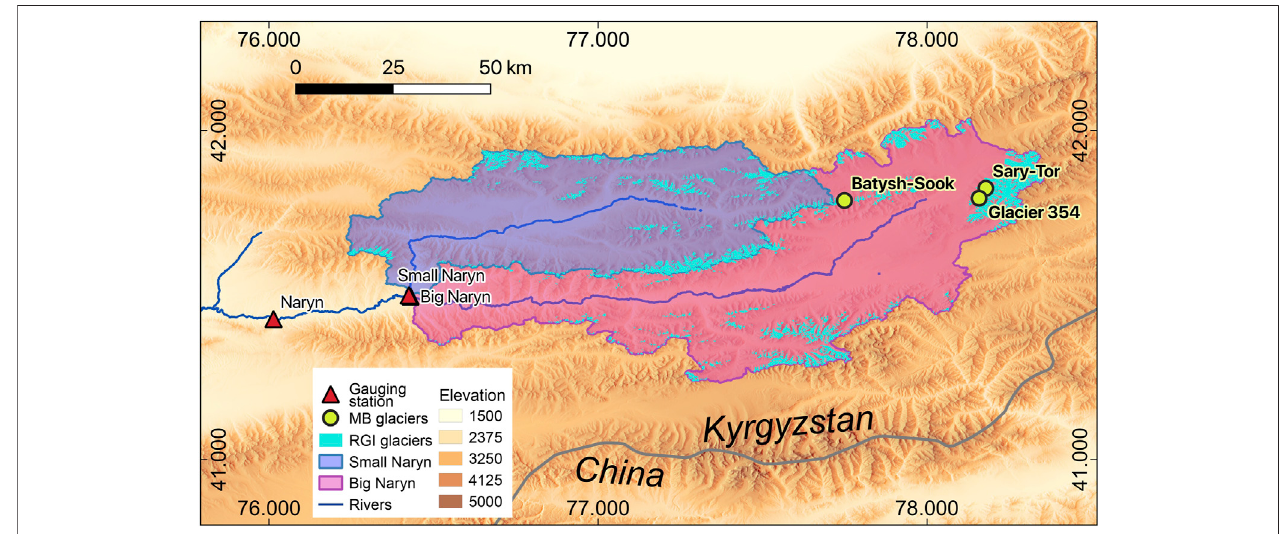
FIGURE 1 | Map of the study area. Glaciers with mass balance observations are indicated with yellow